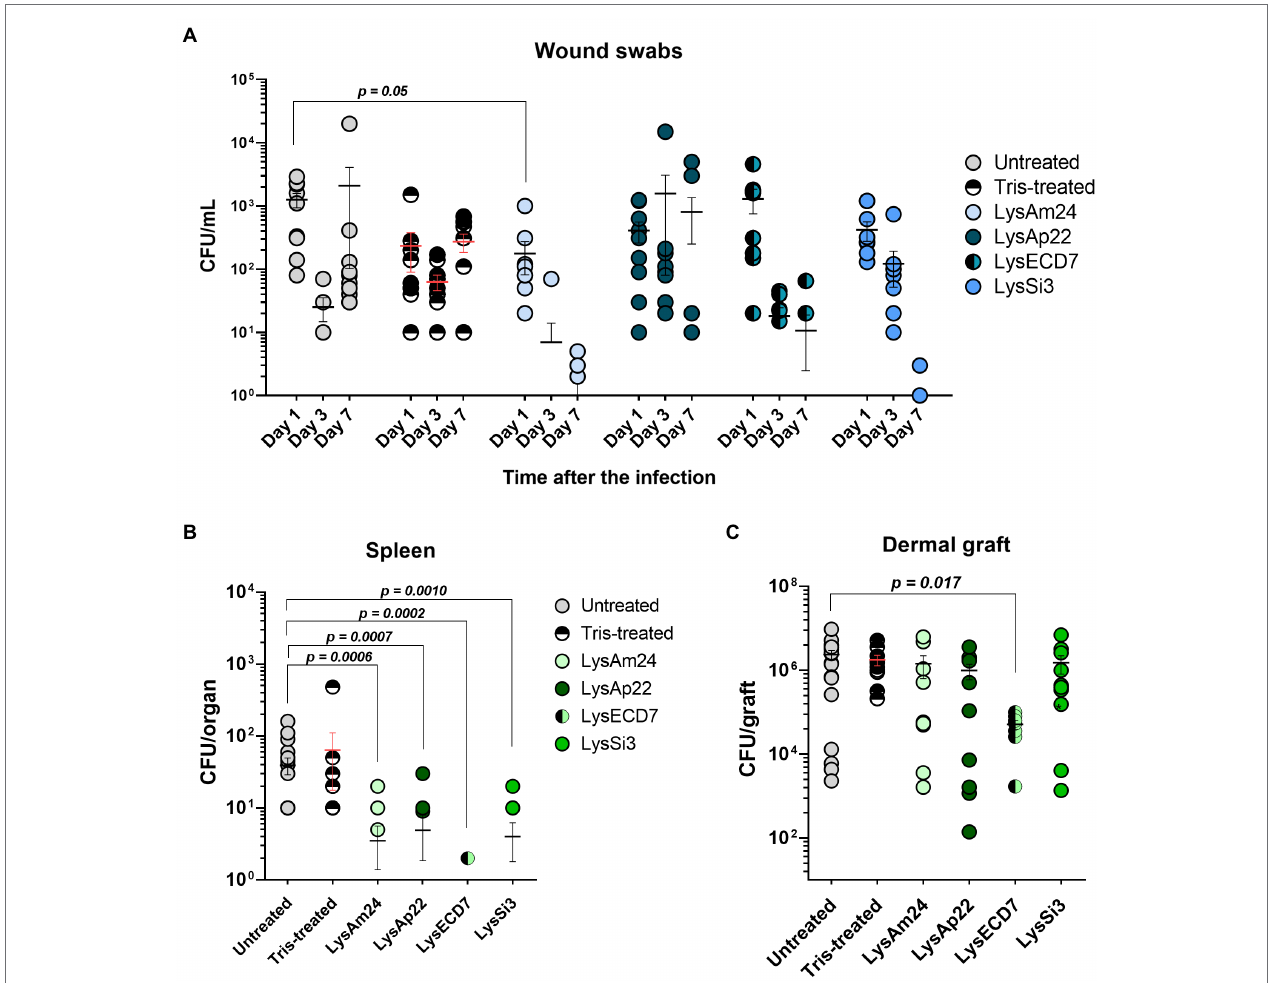
FIGURE 5 | Skin wound model of outbred mice infected with the K. pneumoniae Ts 141-14 strain and epicutaneously treated with control buffer or 500- μ g/ml endolysins solutions. (A) Bacterial counts in the wounds resulting from swabs of the infected areas. Significant differences are shown as p values; otherwise, no statistical difference was found (two-way ANOVA with Sidak multiple-comparison test). Spleen (B) and dermal graft (C) microbial load on the seventh day of the experiment. Significant differences are shown as p values; otherwise, no statistical difference was found (Mann–Whitney test). The resulting CFU/mL, CFU/graft, or CFU/organ values from each animal are plotted as individual points. Data are shown as mean ±